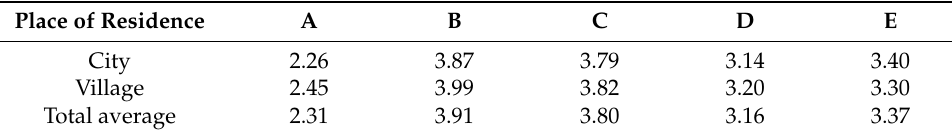
Table 2. Respondents’ opinions on the average importance of impact on decarbonization.